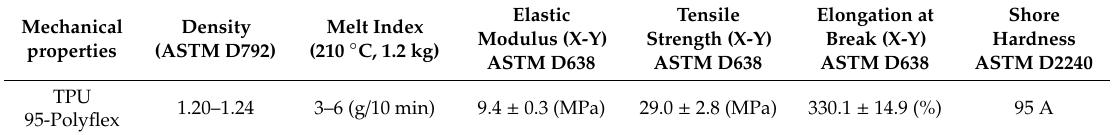
Table 2. Mechanical properties of TPU 95 Polyflex material available on the producer website.